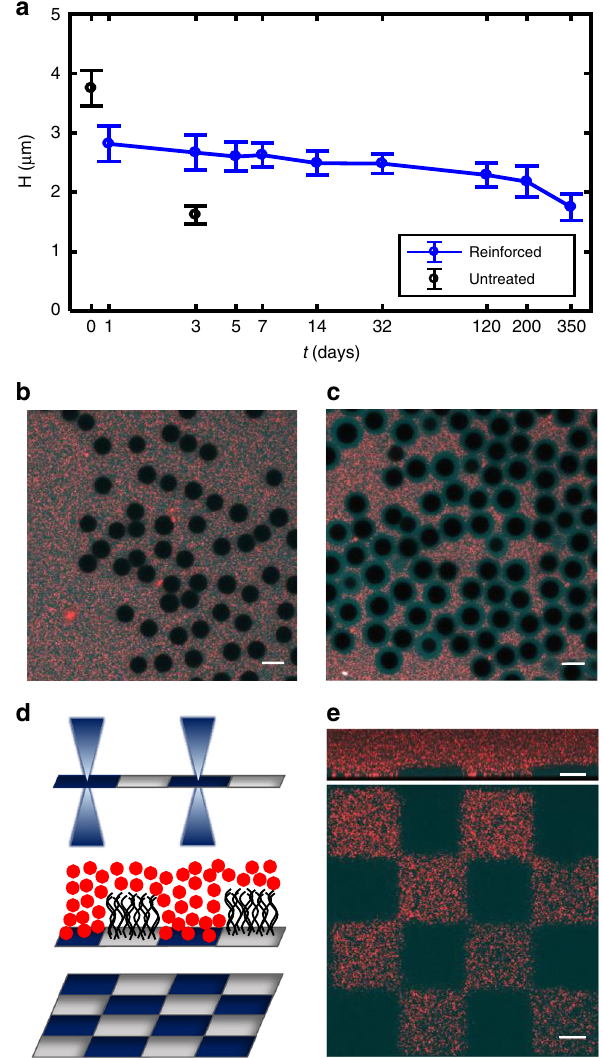
Fig. 5 Reinforcement stabilizes HA brush. a Reinforced spherical brush height measured over a period of 1 year versus natural, untreated spherical brush height. For each time point the corresponding number of measurements are N = 35, 126, 119, 103, 64, 56, 62, 76, 59, 28. Error bars report st. dev. b Reinforced brushes on spherical particles are still digested by hyaluronidase, indicating minimal HA − HA crosslinking within the brush. c Reinforced brushes on spherical particles resist detergent treatment (SDS) despite the removal of membrane fragments. This con fi rms the HA is stably bound to the underlying glass substrate. d UV micropatterning of HA synthase activity with a confocal microscope ( λ = 405 nm). e Checkerboard pattern illustrating binary patterning of the brush. Red regions indicate areas where no brush grew; cyan regions indicate regions where brush expels red nanoparticles. Top: XZ confocal side view of micropatterned brush. Bottom: XY confocal image taken at the glass interface. All data in this fi gure were acquired in physiological conditions (150 mM). All scale bars are 10 µ